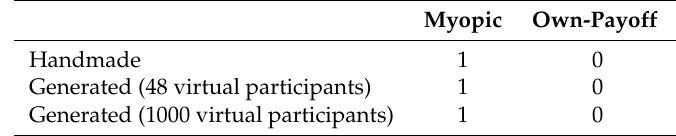
Table 2. Proportions c played for myopic and own-payoff cognitive models in Game 5.